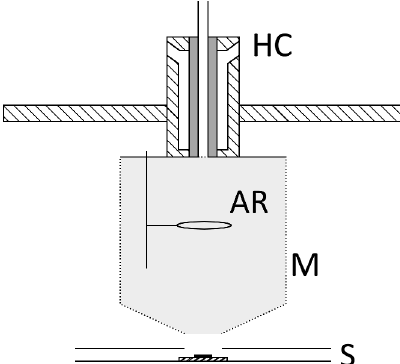
Fig. 4 X-ray diffraction patterns of TiO 2 films grown on Si substrates by HiPIMS at various values of peak target power. The increase of the peak target power and the subsequent increase in the number of ions available during deposition promote the formation of the rutile at the expense of the anatase phase. [Adapted from Aiempanakit et al. (2011).]